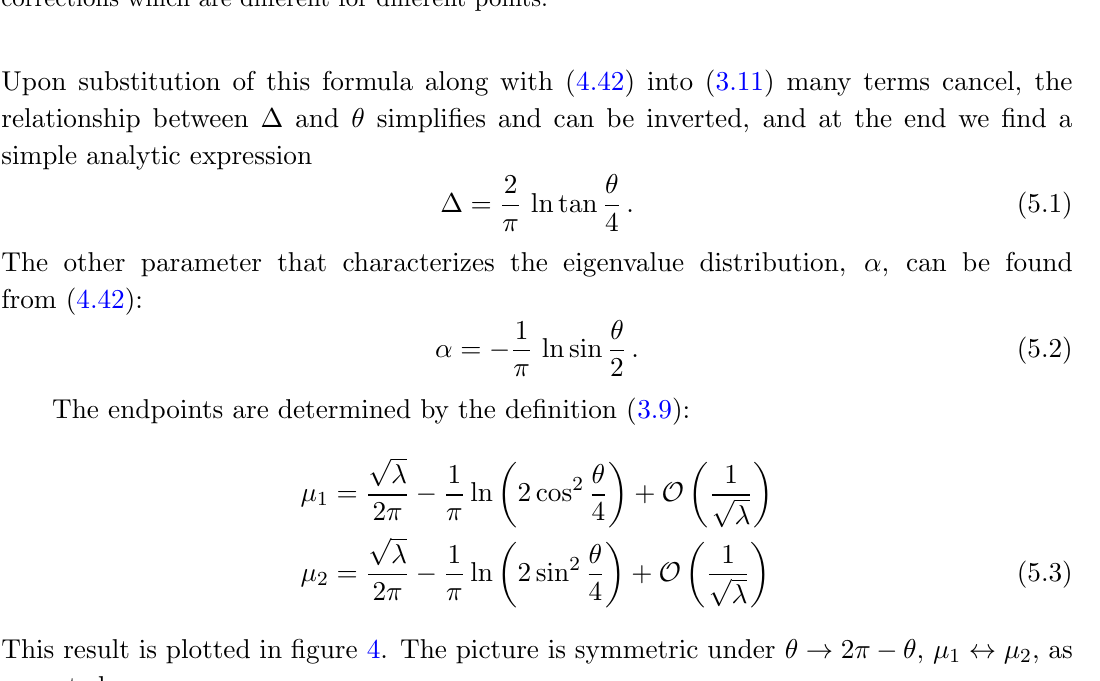
Figure 4 . The endpoint positions relative to the mean-(cid:12)eld value (cid:22) = (cid:18) -parameter. The dots are obtained by picking (cid:21) 1 , (cid:21) 2 randomly between 0 and 8000 and numerically solving the integral equations. Certain scatter in the numerical data is due to unaccounted 1 = corrections which are di(cid:11)erent for di(cid:11)erent